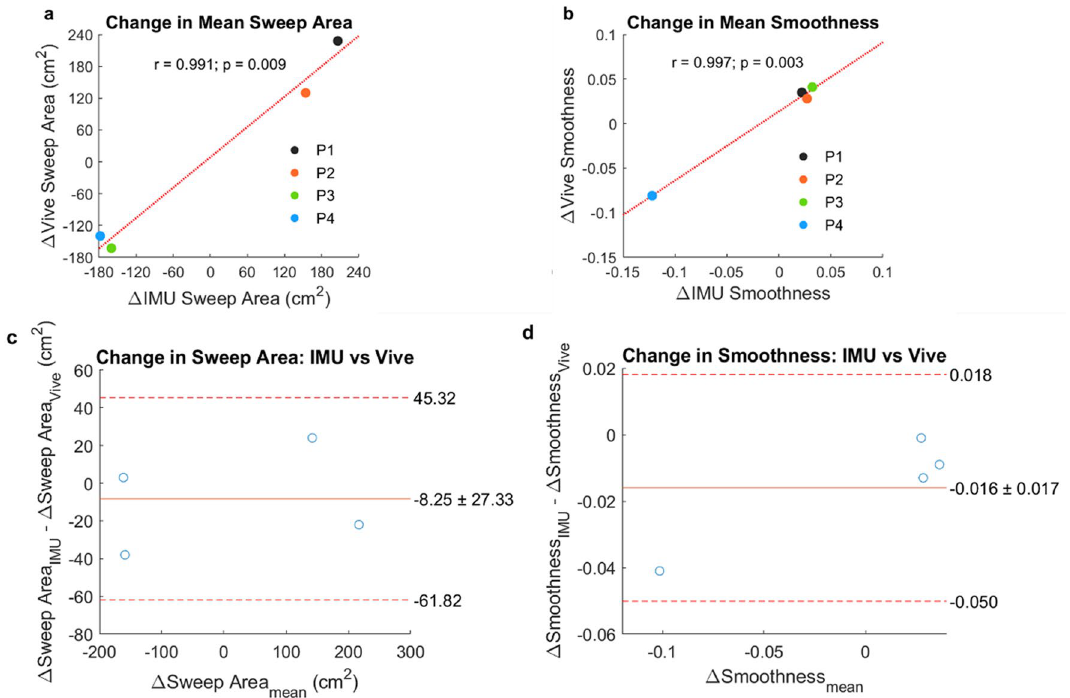
Figure 7. Change in sweep task kinematic metrics. ( a , b ) Change (Δ) in ( a ) mean sweep area and ( b ) mean smoothness between the baseline and later weeks for P1, P2, P3, and P4. c , d , Bland–Altman plots comparing the changes in ( c ) mean sweep area and ( d ) mean smoothness estimated by the IMUs and